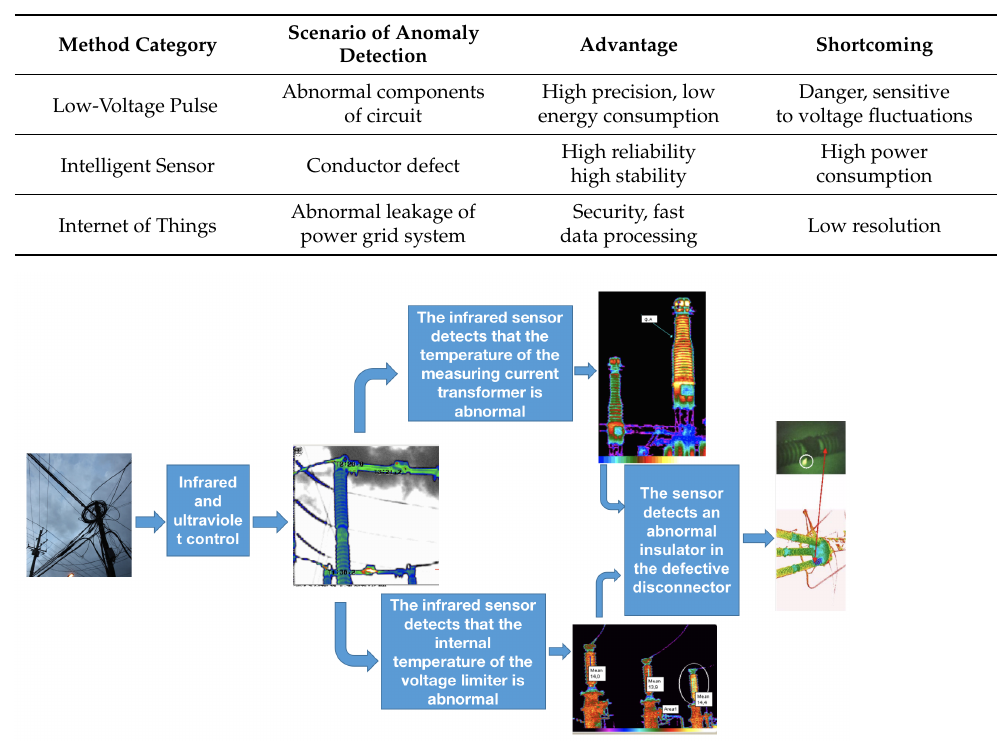
Figure 1. The abnormality detection of power grid insulators using low-voltage pulse and infrared sensing detection